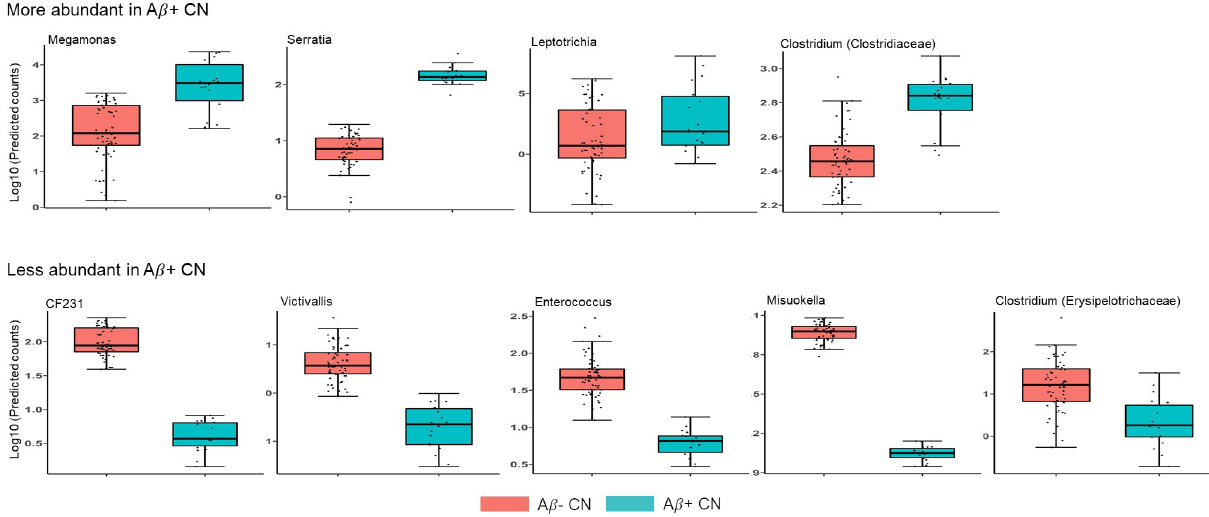
Fig 1. Log predicted counts of the genera associated with A β positivity. Prediction was made using GLM analysis adjusted for age, gender, BMI, APOE4 positivity. Only genera with q < 0.05 are shown. Abbreviation. A β : amyloid beta; GLM: generalized linear model; A β + CN: cognitively normal participants with amyloid retention A β − CN: cognitively normal participants without amyloid retention; APOE4: apolipoprotein E ε 4; BMI: body mass index.